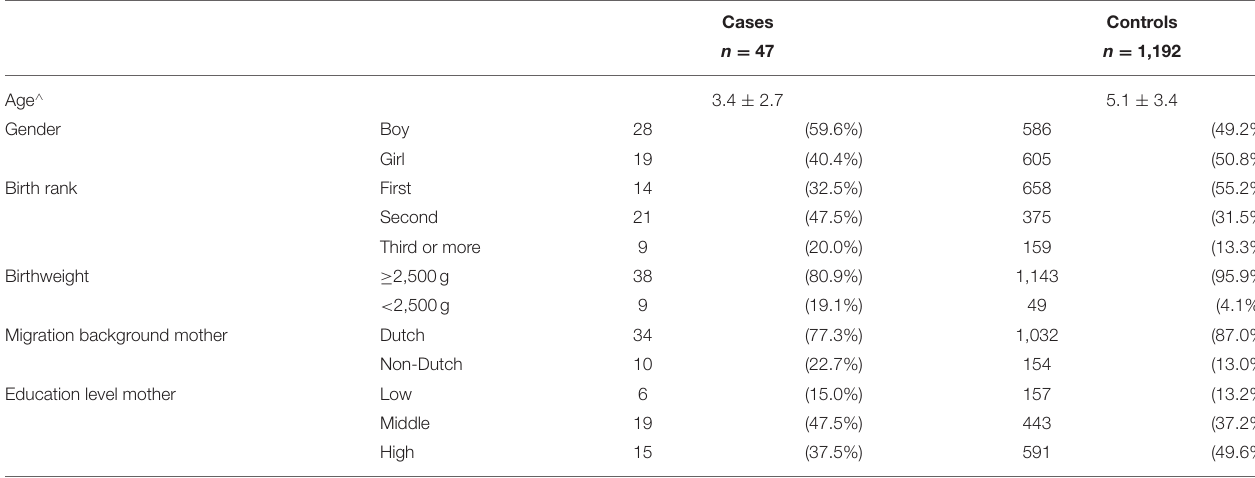
TABLE 1 | Characteristics of cases and controls.